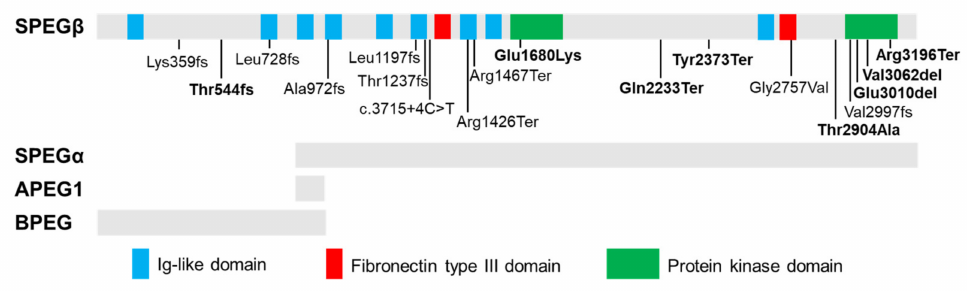
Figure 1. Tissue-specific isoforms of SPEG and disease-related recessive mutations. Schematic of full-length SPEG protein showing its functional domains, including nine immunoglobulin (Ig)-like, two fibronectin Type III and two protein kinase domains, with positions of identified mutations (homozygous mutations: in bold). The gray bars below the diagram indicate which domains are part of the four SPEG isoforms (SPEG β , SPEG α , APEG1, and BPEG) as marked below. Speg α and Speg β are predominantly expressed in skeletal and cardiac muscle; APEG1 is expressed predominantly in vascular smooth muscle cells (VSMCs); BPEG is expressed exclusively in brain and